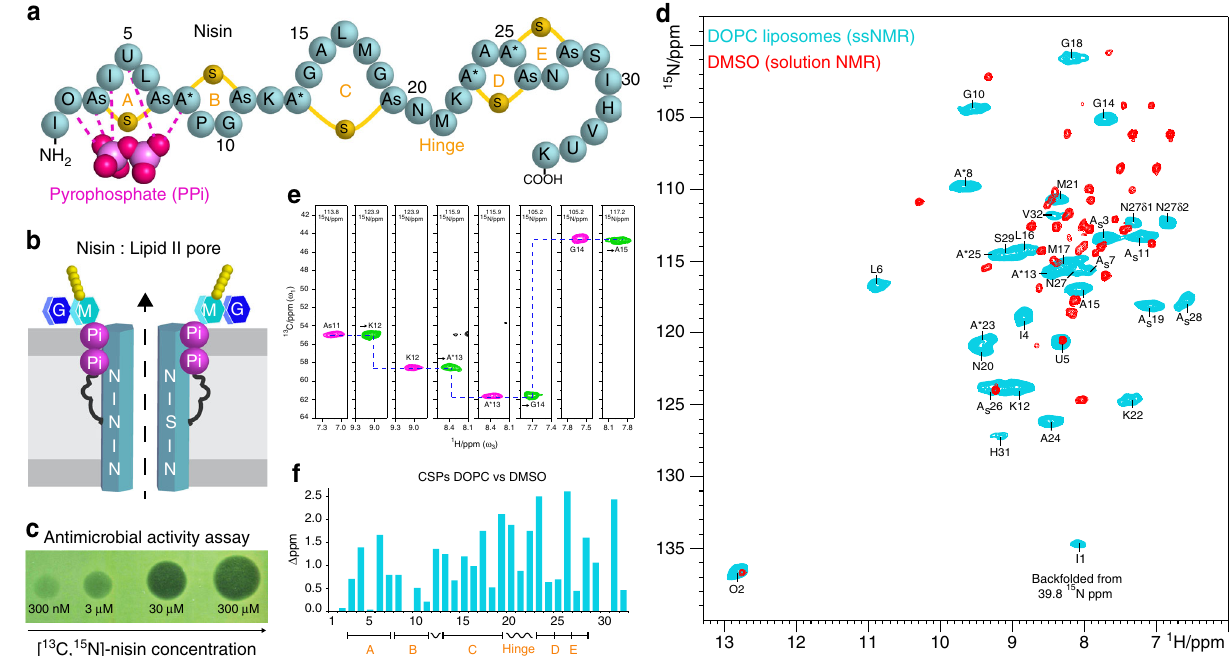
Fig. 1 ssNMR experiments of the lipid II – nisin complex in DOPC liposomes. a Illustration of the nisin Z peptide – antibiotic. The thio-ether rings are named A – E. Rings A – B are supposed to interact via fi ve hydrogen bonds with lipid II 13 . The non-canonical residues A s , A*, O, and U are described in Supplementary Fig. 3. b Nisin and lipid II form a de fi ned pore that spans the bacterial plasmamembrane. See Supplementary Fig. 3 for the lipid II structure. c A “ spot-on- the-lawn ” assay shows antimicrobial activity of [ 13 C, 15 N]-labeled nisin. d Overlay of 1 H-detected 2D 15 N – 1 H spectra of the nisin – lipid II complex in DOPC (blue) and DMSO (red). We measured the ssNMR spectrum of nisin bound to lipid II in the pore state (2:1 stoichiometry) in DOPC at 950 MHz ( 1 H- frequency) and 60 kHz MAS. The solution NMR spectrum in DMSO was previously published 13 and shows a 1:1 nisin:lipid II complex. e Sequential assignments of lipid II-bound nisin in liposomes. Strip plots are shown from 3D CANH (magenta) and CAcoNH (green) ssNMR experiments. f Chemical shift perturbations (CSPs) comparing lipid II-bound nisin in DOPC and DMSO. CSPs were calculated according to CSP